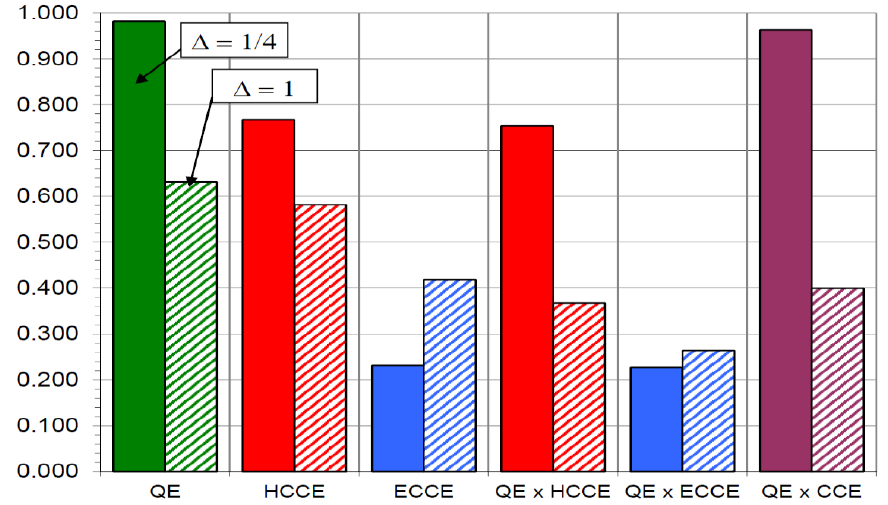
Figure 7. The comparison of A (QE) and  (CCE) contributions to the x-ray sensitivity Q CC for two different attenuations, i.e ., for two different photon energies. Full colors are for  = 1/4 (  = L /4) and hatched colors are for  = 1 (  = L ). HCCE and ECCE are the hole and electron collection efficiencies respectively. The radiation receiving electrode is positively biased. For a unipolar semiconductor either HCCE or ECCE would be